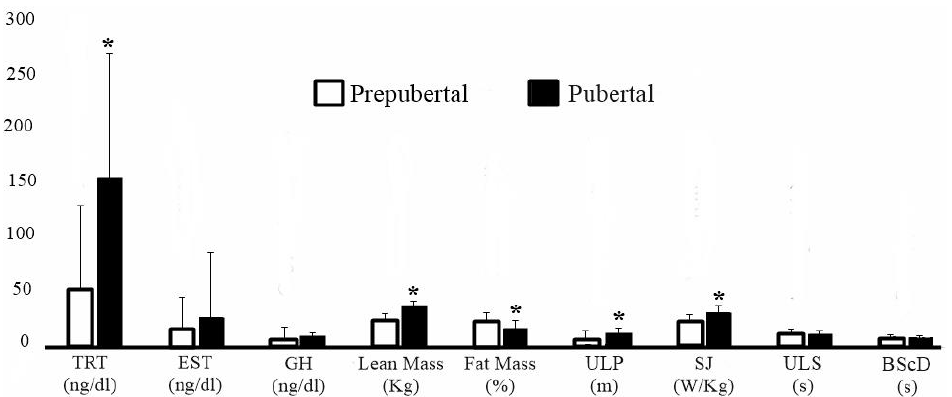
Figure 2. Comparison according to the stage of sexual maturation.